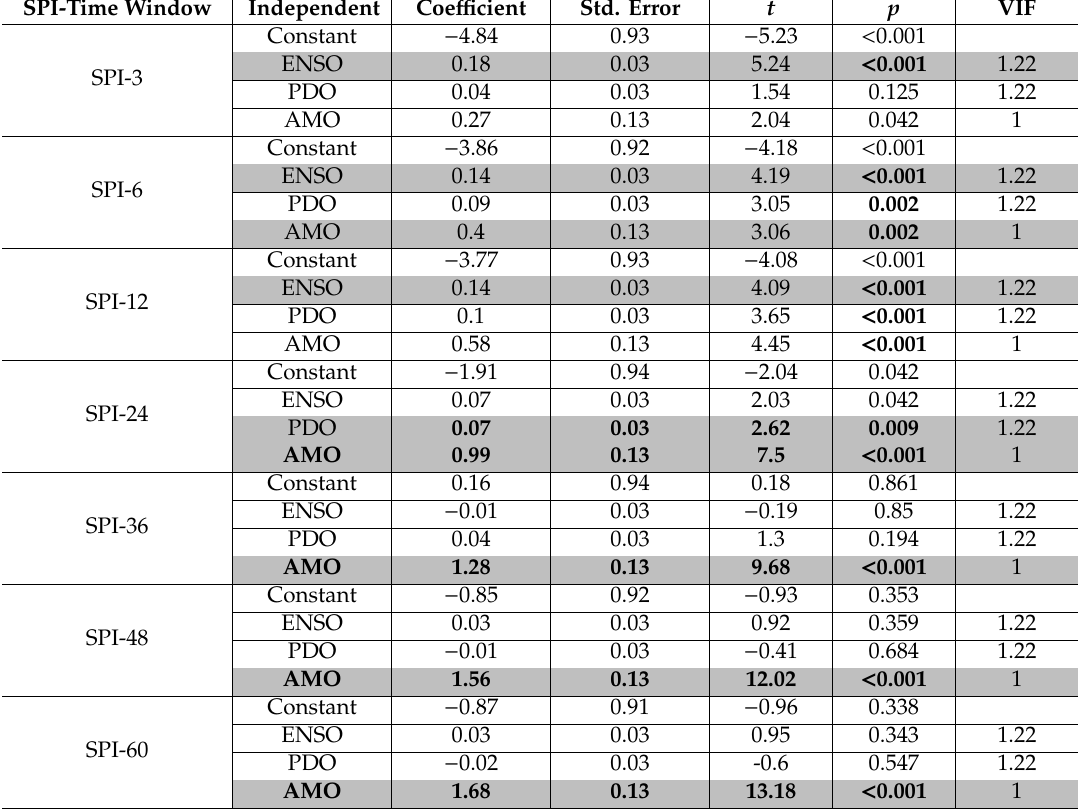
Table 3. Multiple regression test statistics of SPI-3, SPI-6, SPI-12, SPI-24, SPI-36, SPI-48, and SPI-60 against ENSO, PDO, and AMO. The significance of the t -test statistics is evaluated at 95% confidence interval. Two-tailed t -test statistics is applied; therefore, a computed p -value less than 0.025 suggests the significance of the relation between the driver and SPI. The higher Variance Inflation Factor (VIF) represents the presence of high level of multi-collinearity. SPI-Time